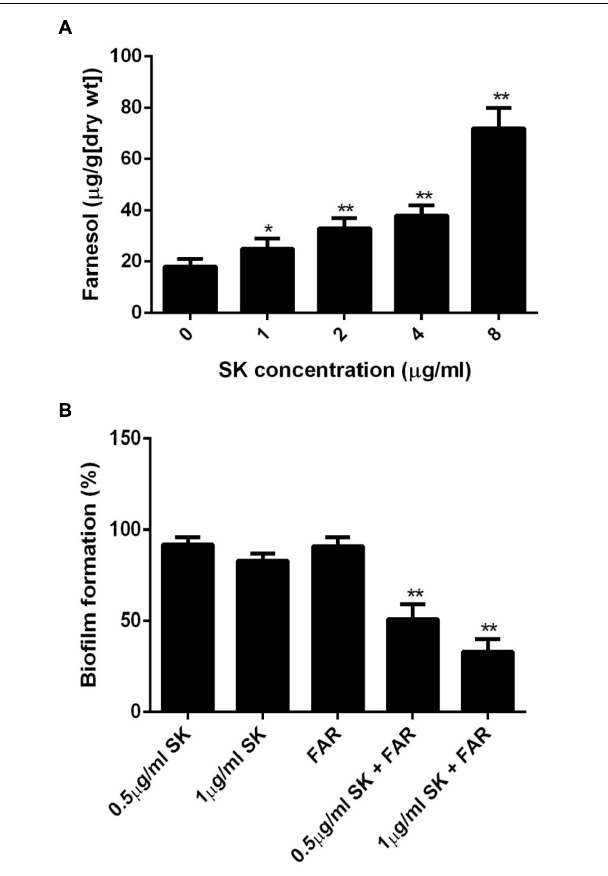
FIGURE 5 | (A) Farnesol production in the supernatant of C. albicans biofilms treated with different concentrations of SK for 24 h. (B) Effect of farnesol on the antibiofilm activity of SK. C. albicans cells were cultured in biofilm formation condition. After 90 min of adhesion, SK (0.5, 1 µ g/ml) or farnesol (25 µ M) or the combination of the two compounds were added and the biofilm growth was continued for 24 h. Biofilm formation was evaluated using an XTT reduction assay, and the results are presented as the percent of compound-treated biofilms relative to the control (compound-free) biofilm. The results represent means ± standard deviations for three independent experiments. ∗∗ P < 0.01 as compared to the corresponding SK-treated alone